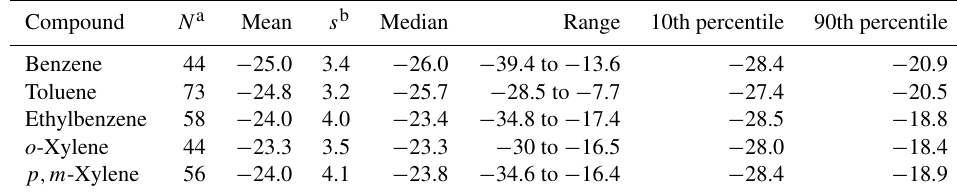
Table 6. Stable carbon isotope composition ( δ 13 C, ‰) of ambient VOC collected in Toronto (2009–2010). Compound N a Mean s b